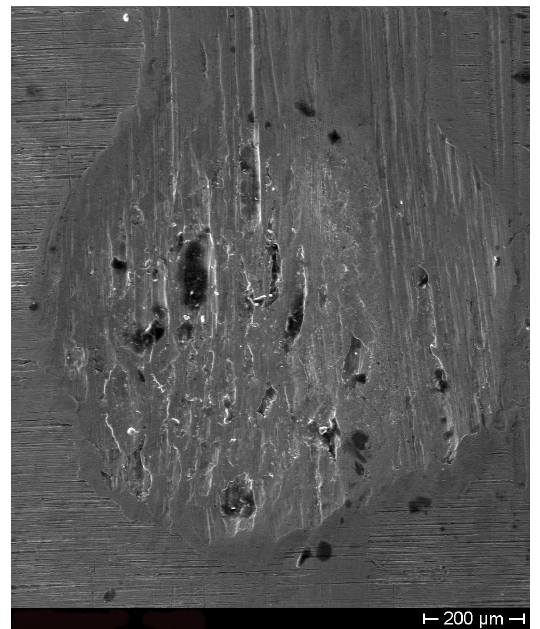
Figure 10: SEM micrograph of a longitudinal wear groove found in the central part of the piston (sample 1).